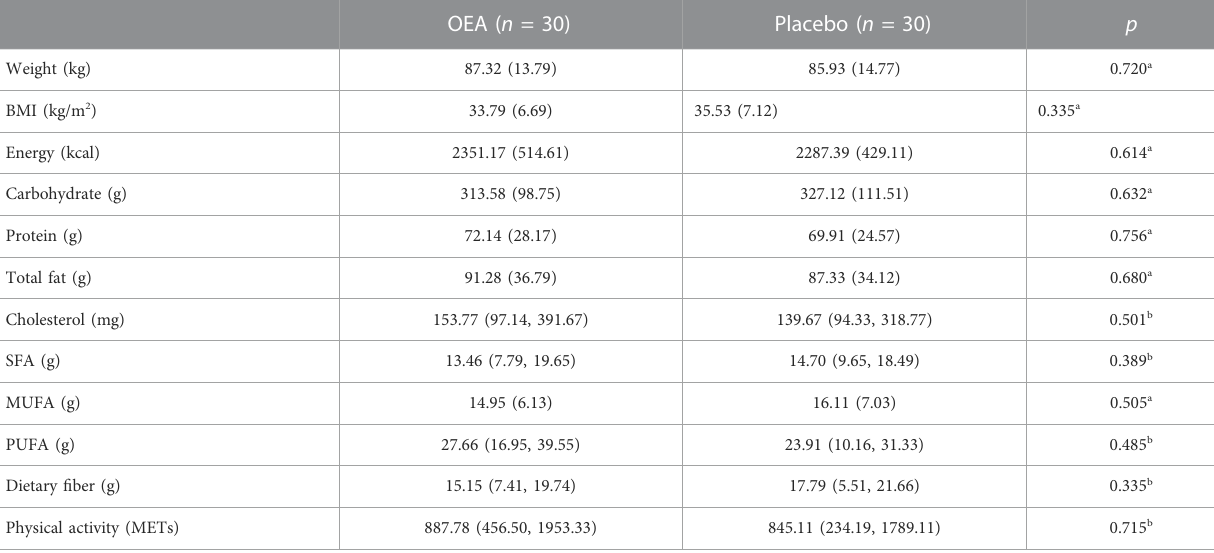
TABLE 2 Anthropometric indices, dietary intake and physical activity of the patients at